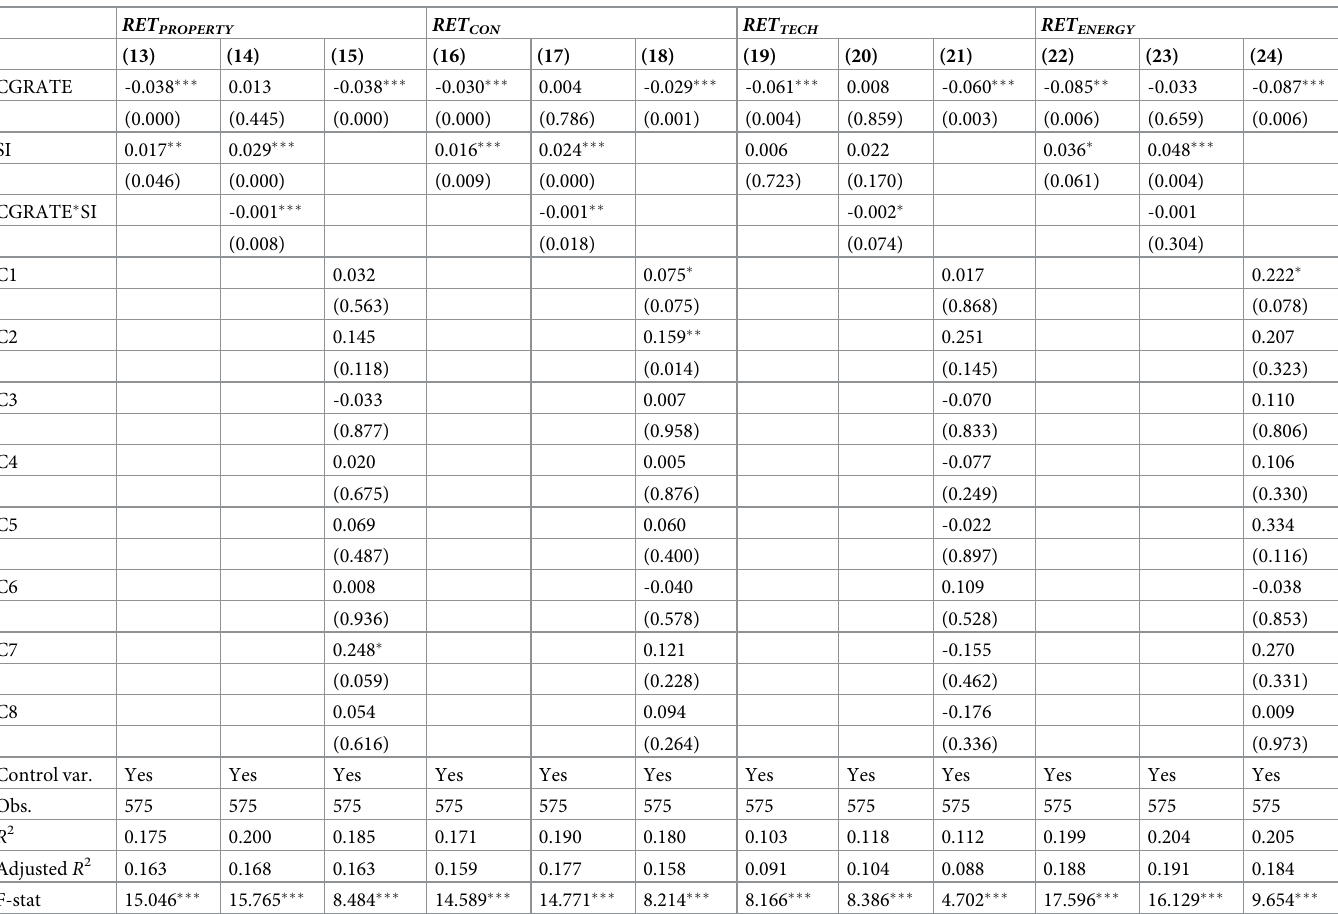
Table 5. Robustness tests: Alternative dependent variables using different sector indices returns. RET